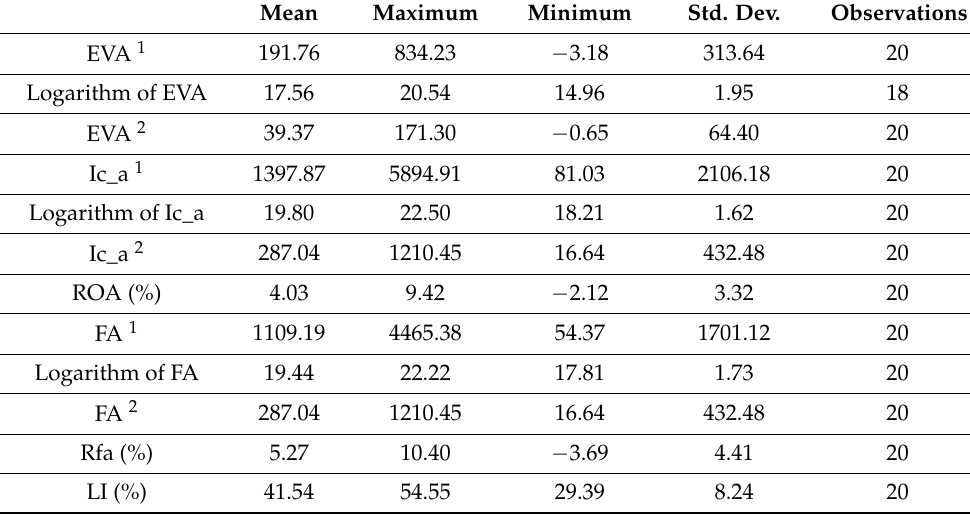
Table 5. Correlation matrix.